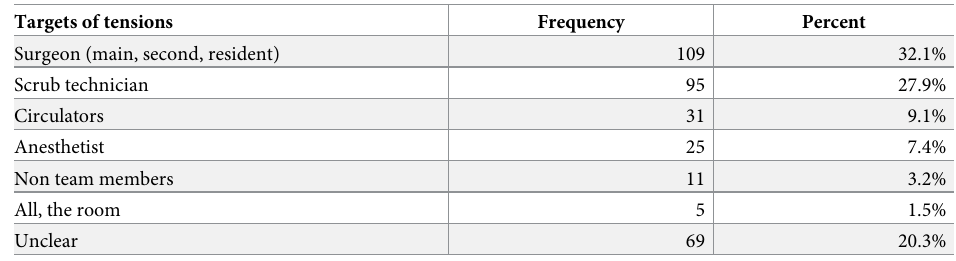
Table 3. Targets of